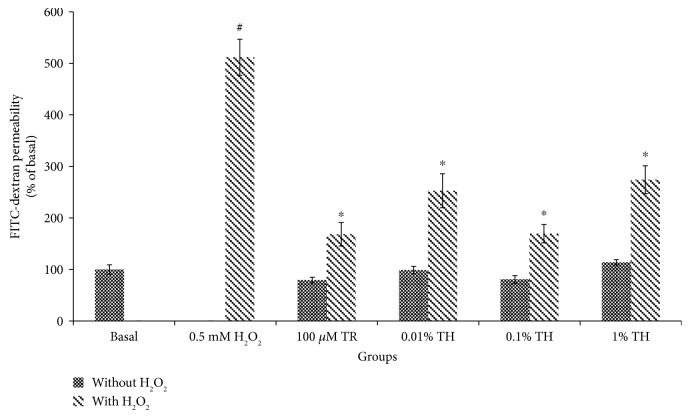
Quantification of FITC-dextran in HUVECs. The permeability (% of basal) of the cells treated with TH with and without the H2O2 group. Values are expressed as the mean ± SEM from three independent experiments. Hash (#) represents the significant difference compared with the basal group (untreated and with media only), p < 0.05; asterisk (∗) represents the significant difference compared to the H2O2 group, p < 0.05. Basal = untreated; TR = Trolox; TH = Tualang honey.